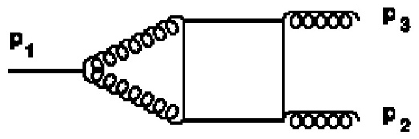
Figure 6. Planar 2-loop